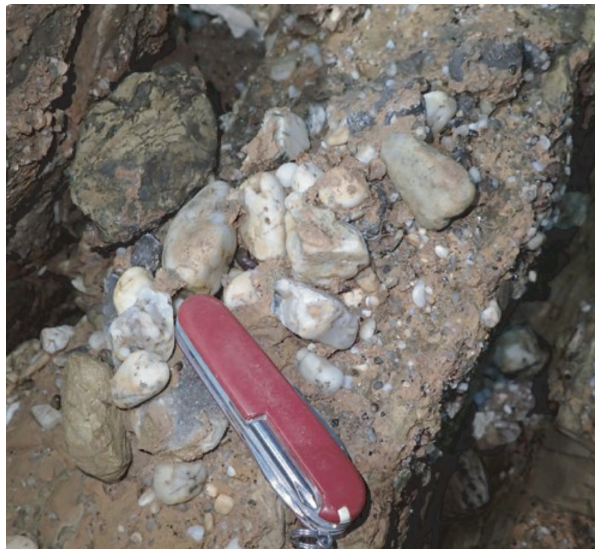
Figure 3. Example of quartz cobbles sampled for burial dating. Lo- cation: Cuillère Cave (Site 1, Fig.